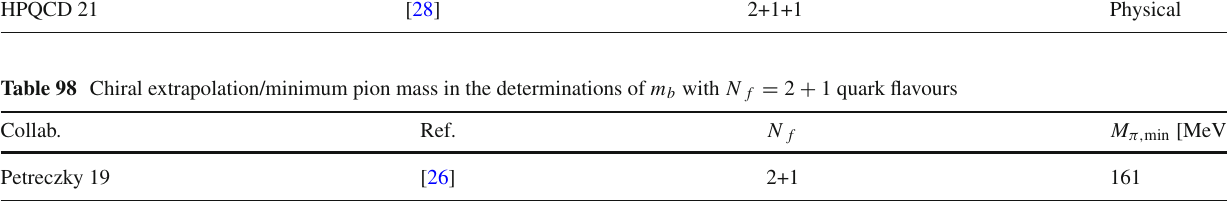
Table 99 Finite-volume effects in the determinations of m b with N f = 2 + 1 + 1 quark flavours Collab.